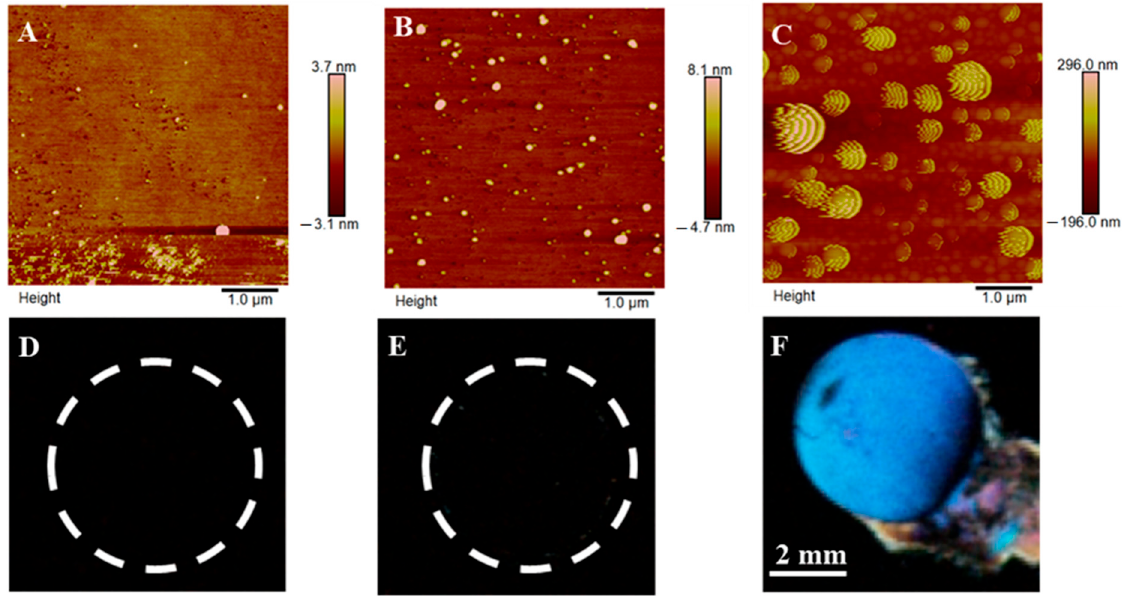
Figure 5. AFM images of different slide surfaces: ( A ) with DMOAP coating; ( B ) after B40t77 aptamer (8 µg/mL) immobi- lization; ( C ) after addition of gp-120 (8 µg/mL), and the corresponding polarized optical images of LCs supported on different slide surfaces; ( D ) coated with DMOAP; ( E ) with B40t77 aptamer (8 µg/mL) modification; ( F ) after addition of gp-120 (8 µg/mL).